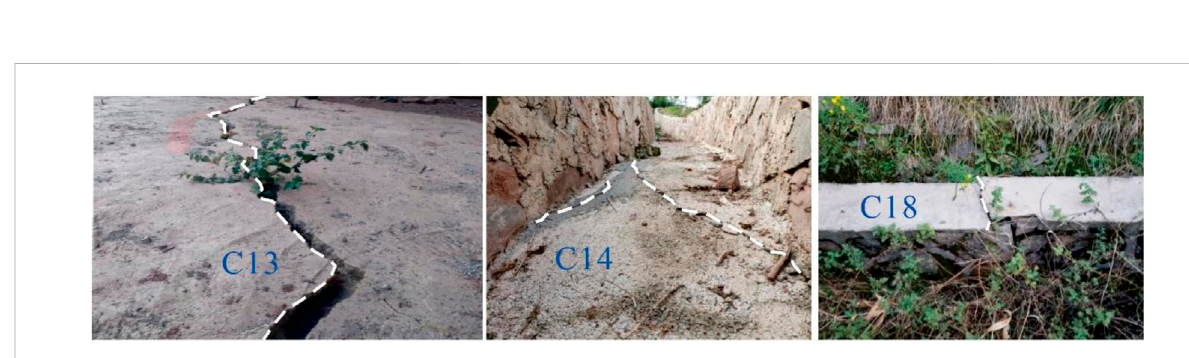
FIGURE 6 The typical old cracks developed in 2007 and 2008 due to deformation of the old Dashuitian